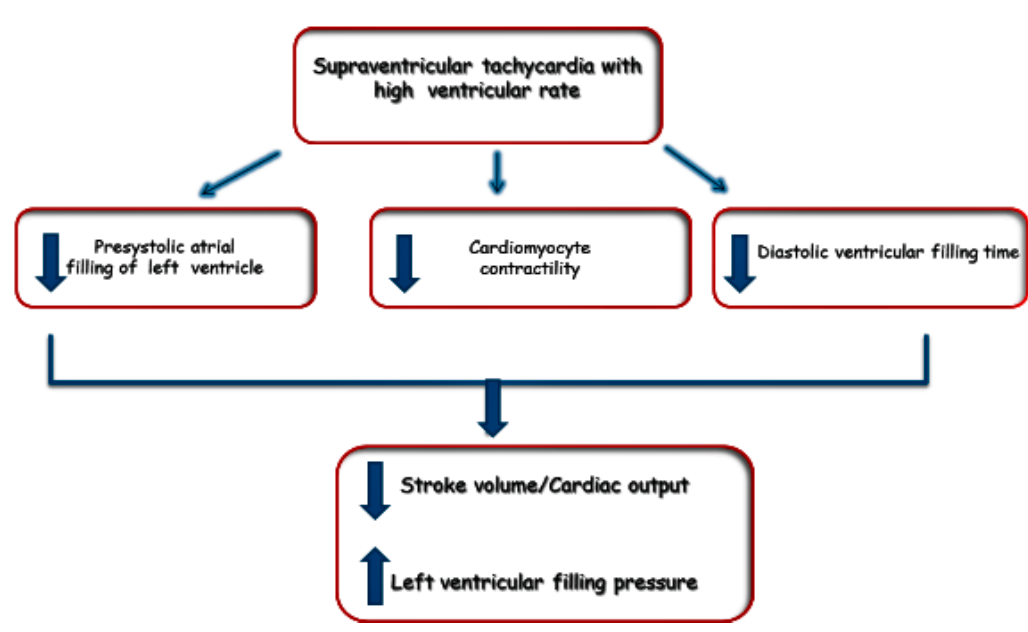
Figure 1. Hemodynamic effects of supraventricular tachycardia.